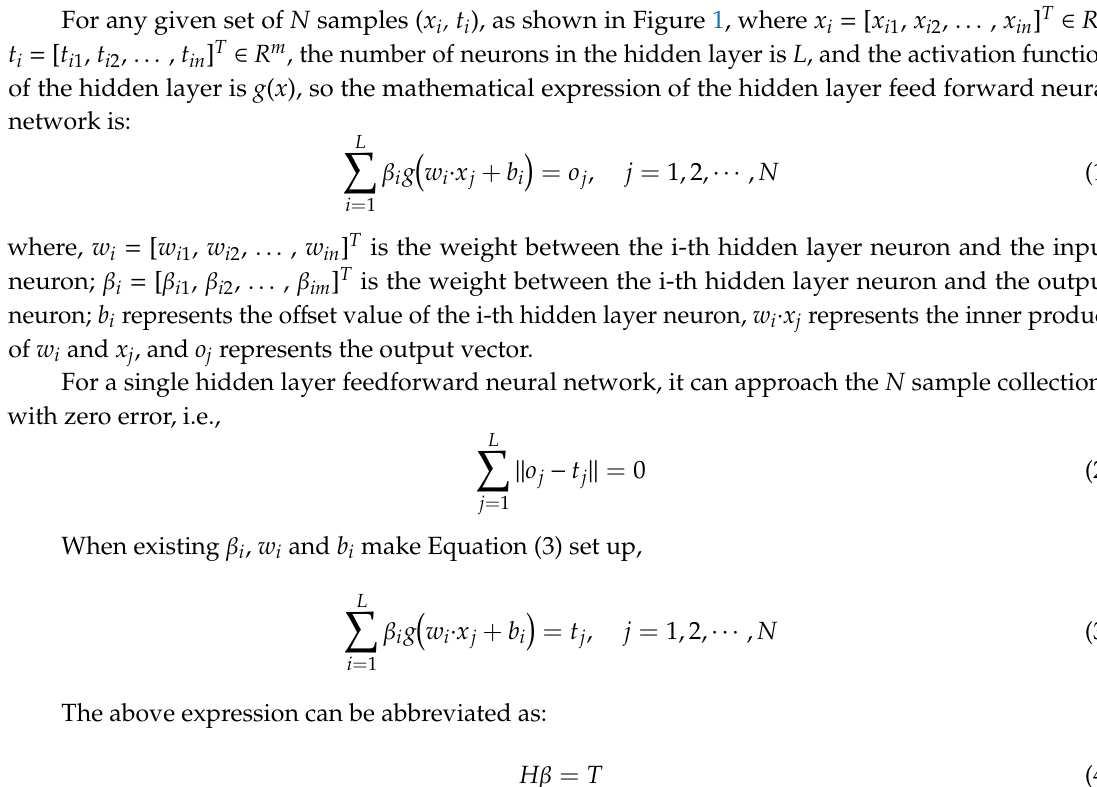
Figure 1. Kernel extreme learning machine (KELM) model structure.